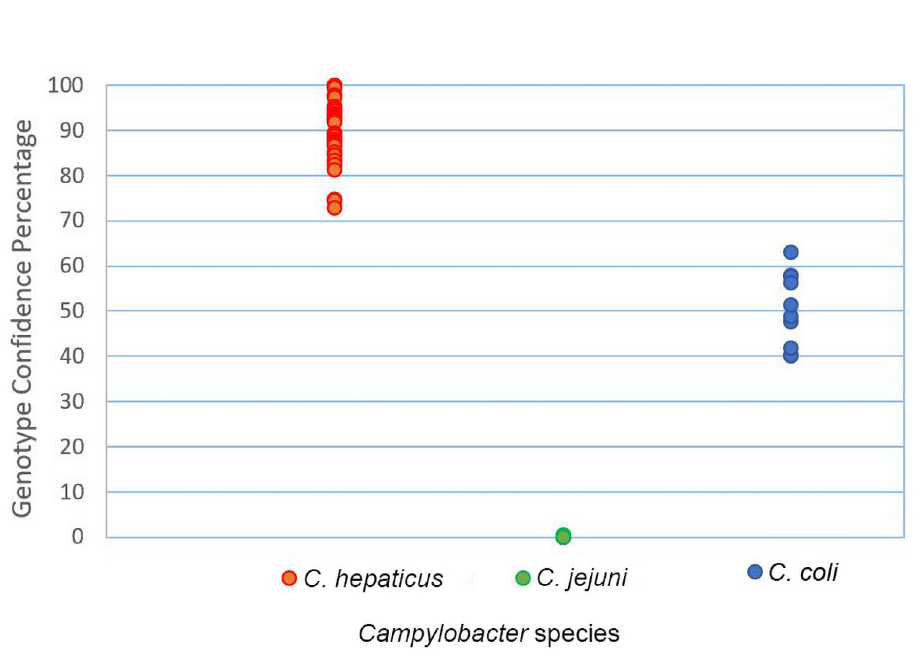
Fig 3. Comparison of the distribution of GCPs from C . jejuni and C . coli isolates by individual value plot when C . hepaticus (VH10) was used as reference